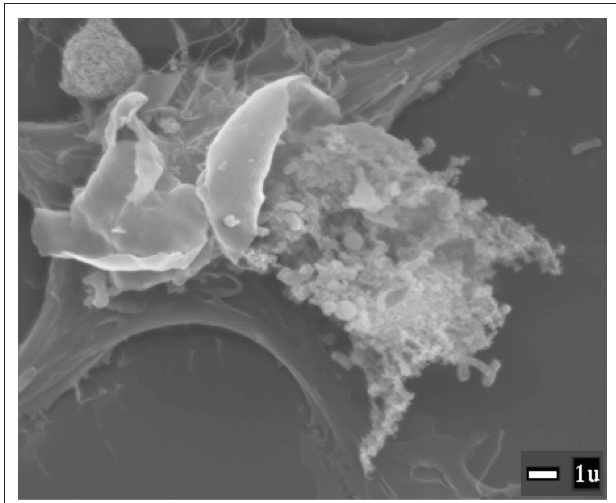
Figure 1 | Francisella novicida being released from a lysed macrophage. SEM image provided by M. Neal Guntzel and Annette R.